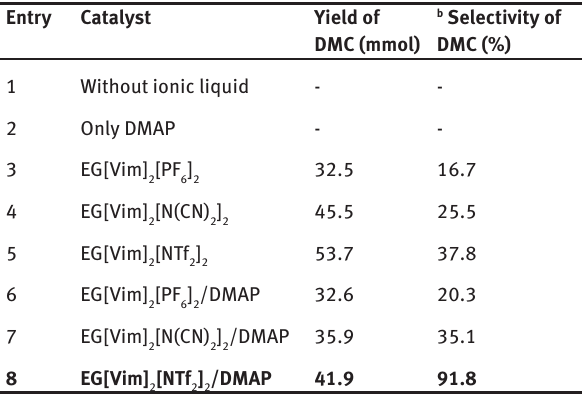
Table 1: Catalytic performance of ILs on dimethyl carbonate production.